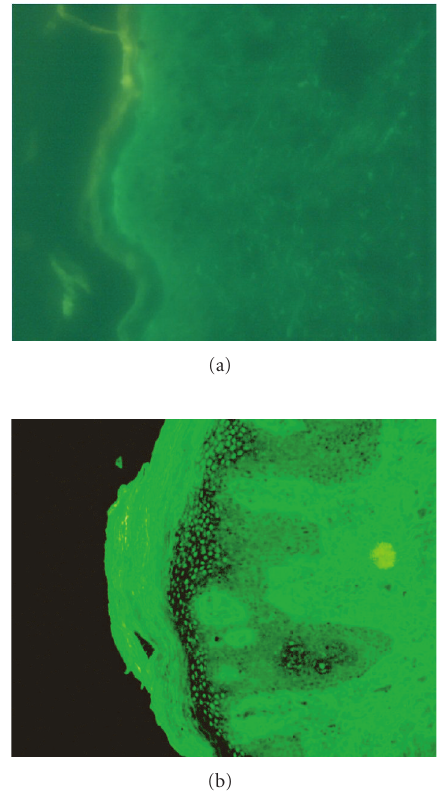
Figure 1: (a) Fluorescent microscopic view of the nonlesional skin biopsy material of psoriatic patient. There is no fluorescent stain- ing. (b) Fluorescent microscopic view of the psoriatic skin biopsy material of the same patient. There is positive fluorescent staining which is the accumulation areas of oxidized low-density lipoprotein